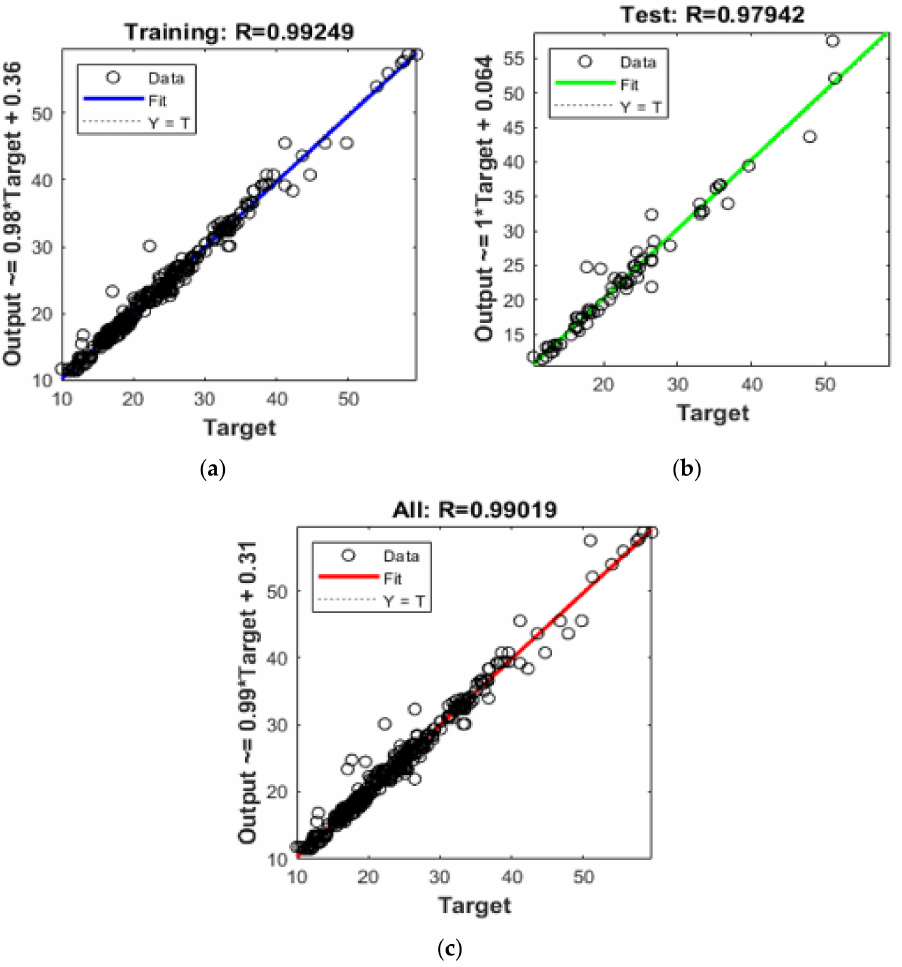
Figure 9. Correlation between predicted and actual GPC compressive strength for three-layer BRANN. ( a ) Training Data; ( b ) Testing Data; ( c ) All